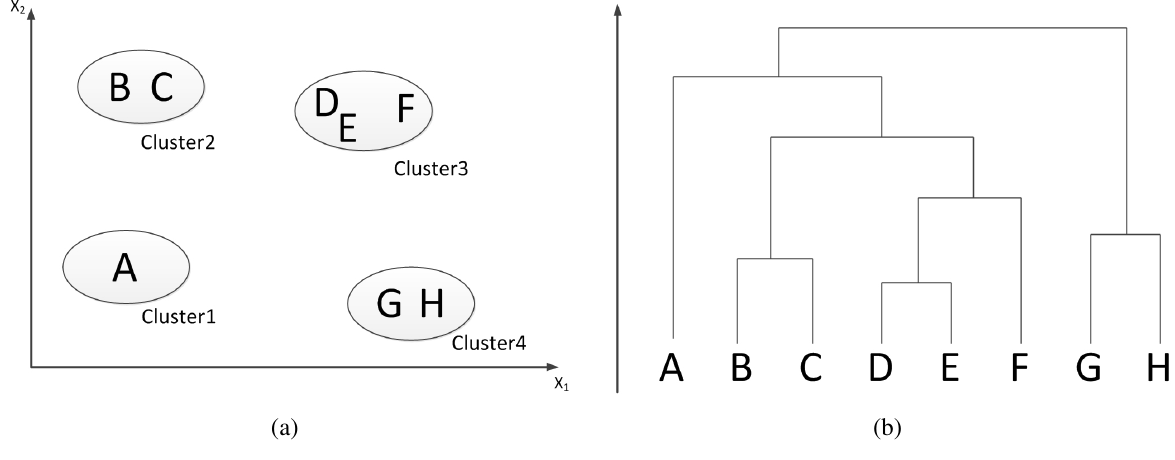
Figure 5. Illustration of hierarchical clustering algorithm. (a) Points fall into four clusters, (b) Dendrogram yielded by the